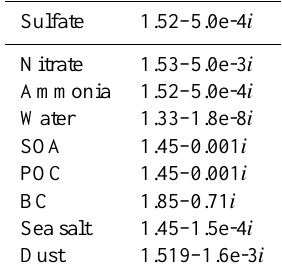
Table 1. Refractive indices used for the aerosol components at